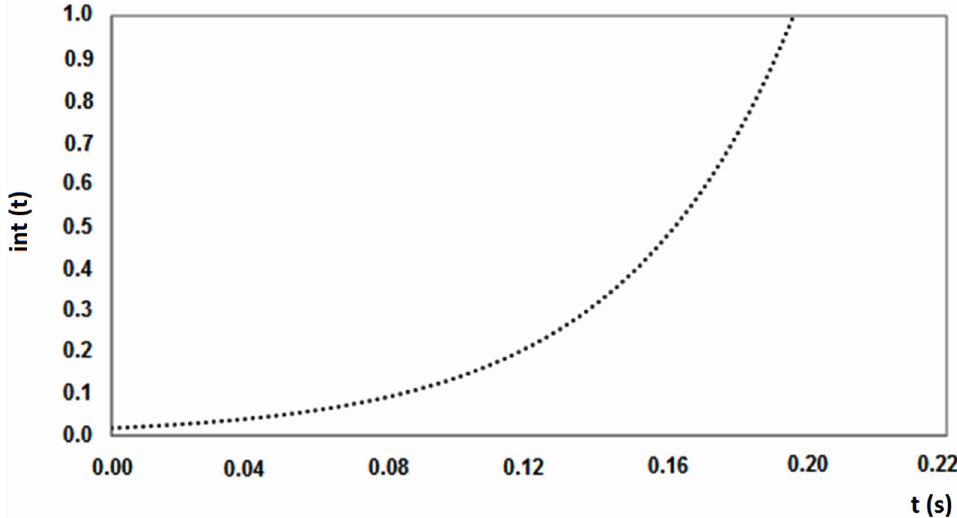
Figure 12. Time function according to the shutter characteristics.